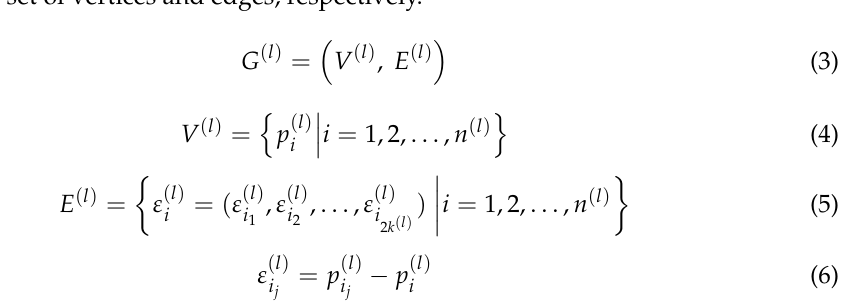
Figure 4. Example of edge feature generation by computing the vectors between the vertex p from its corresponding nearest and farthest neighbors sampled by FPS and KNN.